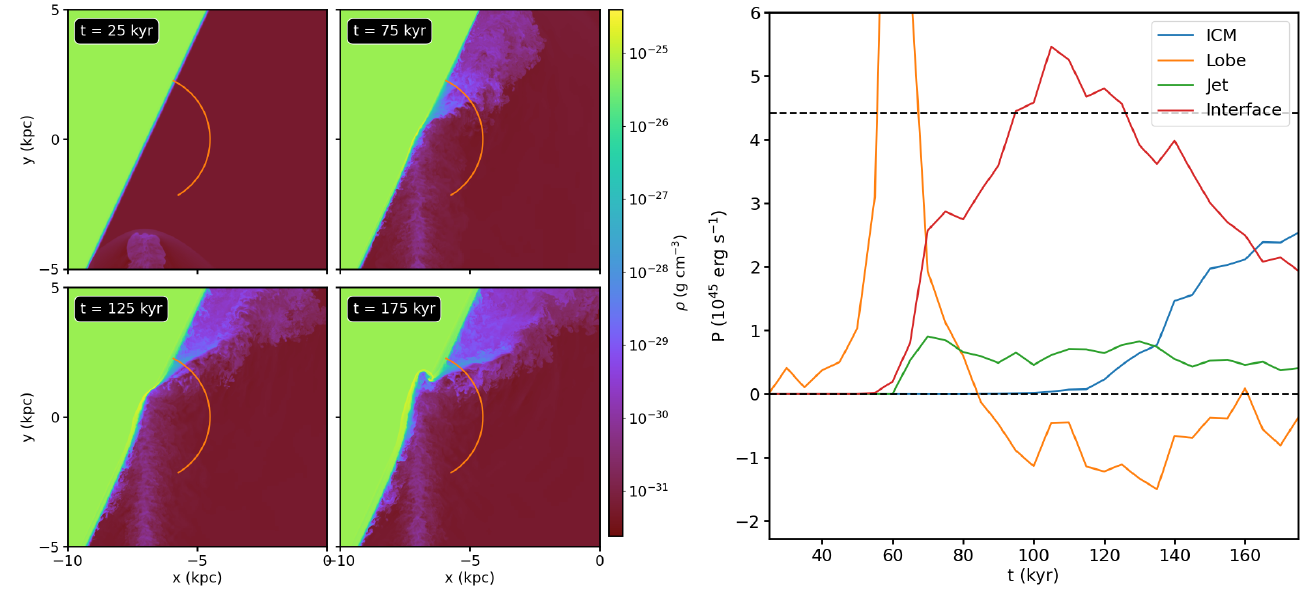
Figure 6. The kinetic and thermal power of the reflected jet in the “fiducial” simulation flowing through a portion of a spherical surface with a radius of 5 kpc, centered on the location where the jet collides with the interface. ( Left panels) Slices through the gas density at several epochs, showing the location of the surface in that slice in orange. ( Right panel) The power in the ICM, lobe, interface, and jet components flowing through the surface as a function of